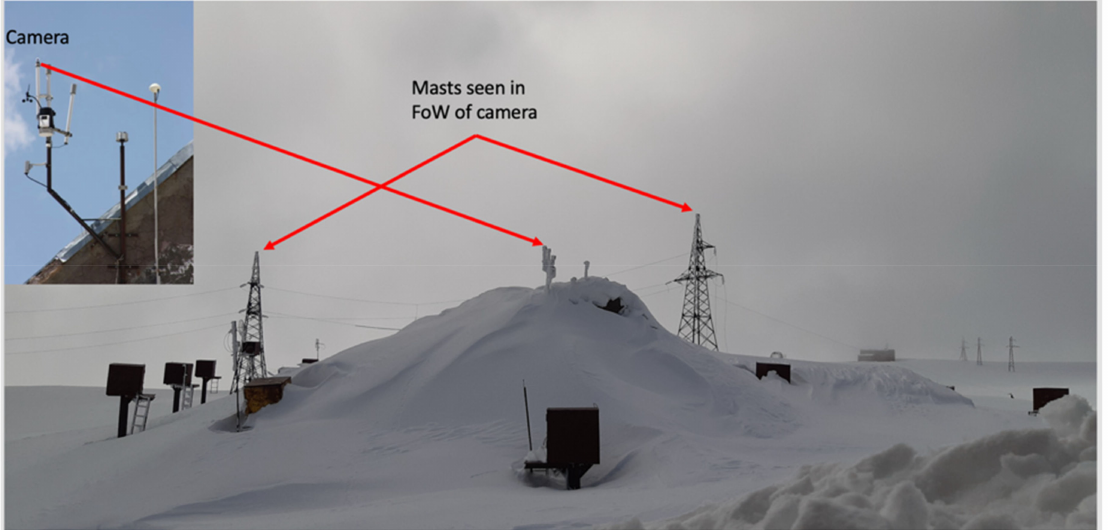
Figure 9. The MAKET experimental hall in winter, in the inset the zoomed ALL SKY CAM surrounded by DAVIS weather station, BOLTEK’s electric field sensor, and lightning